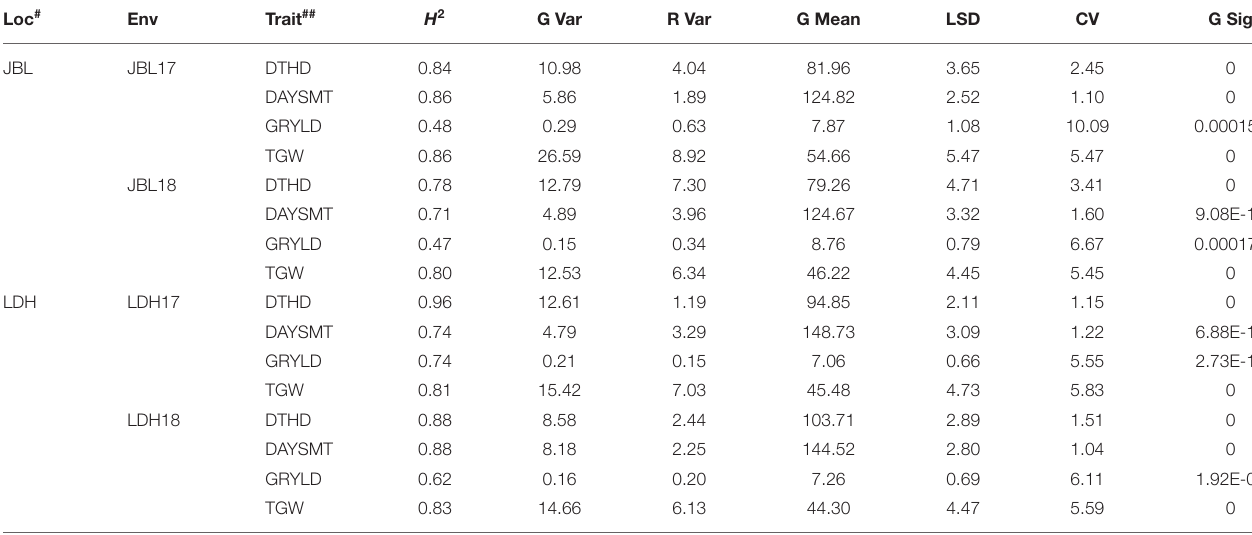
TABLE 1 | Variability analysis of various yield-related agronomic traits for four environments at two locations. Loc # Env Trait ## H 2 G Var R Var G Mean LSD CV G Sig JBL JBL17 DTHD